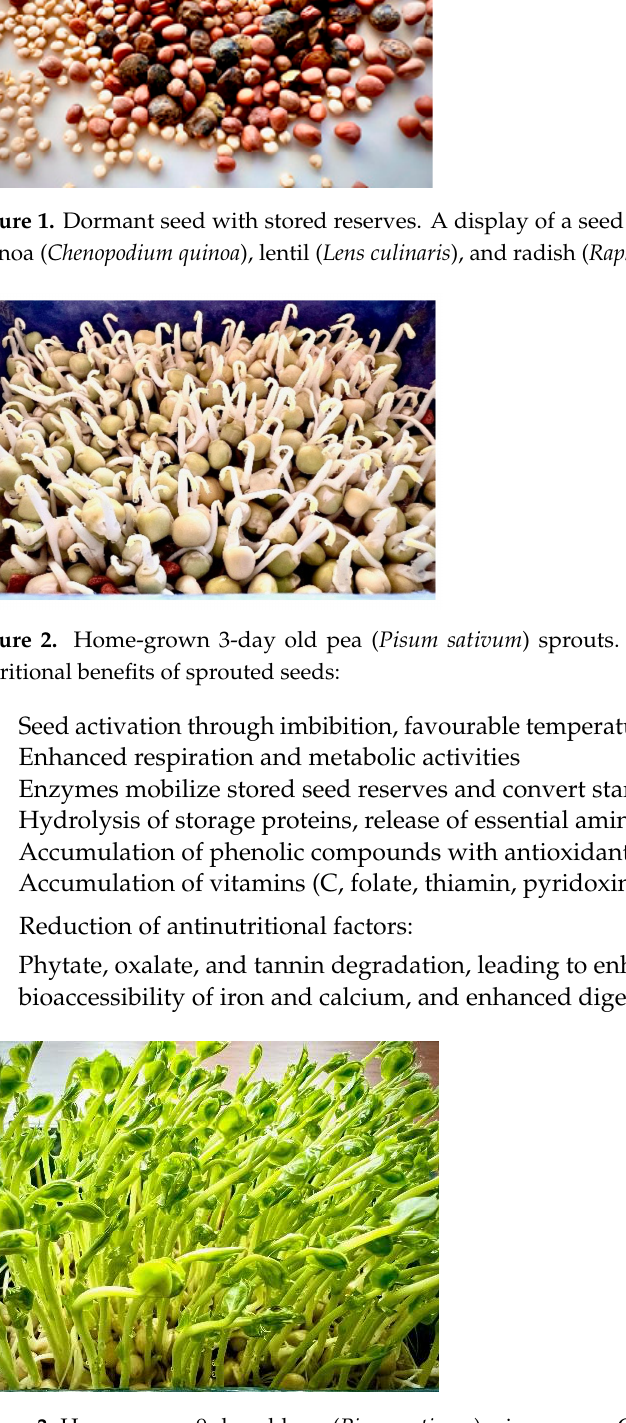
Figure 3. Home-grown 9-day old pea ( Pisum sativum ) microgreens. Commonly recognized nutritional benefits of